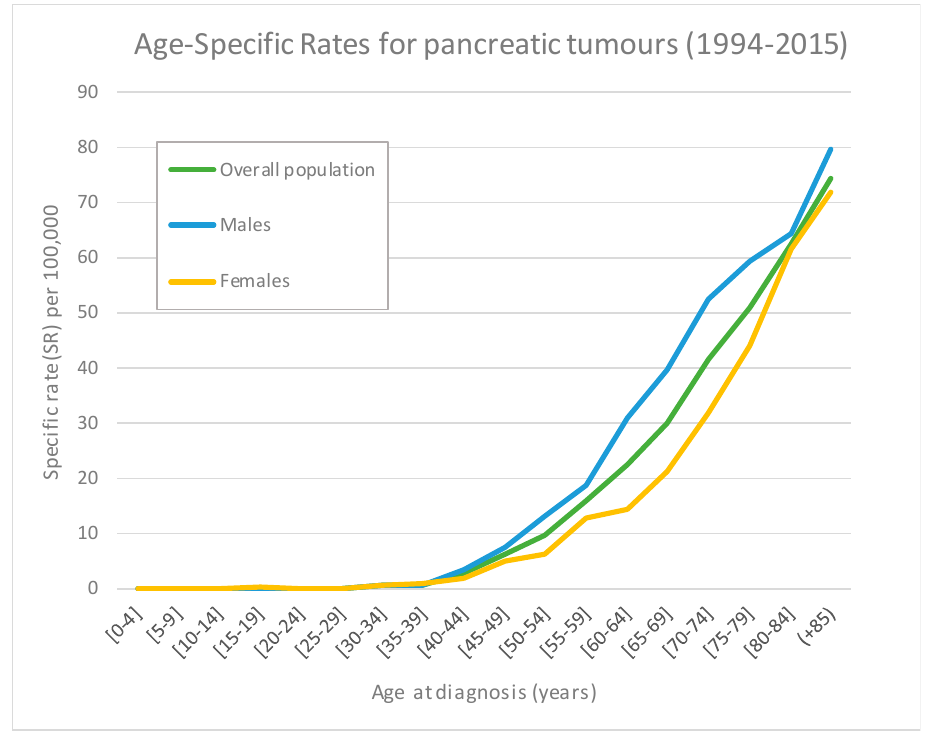
Figure 1. Age-specific incidence rates for pancreatic tumours of the overall population and according to sex.